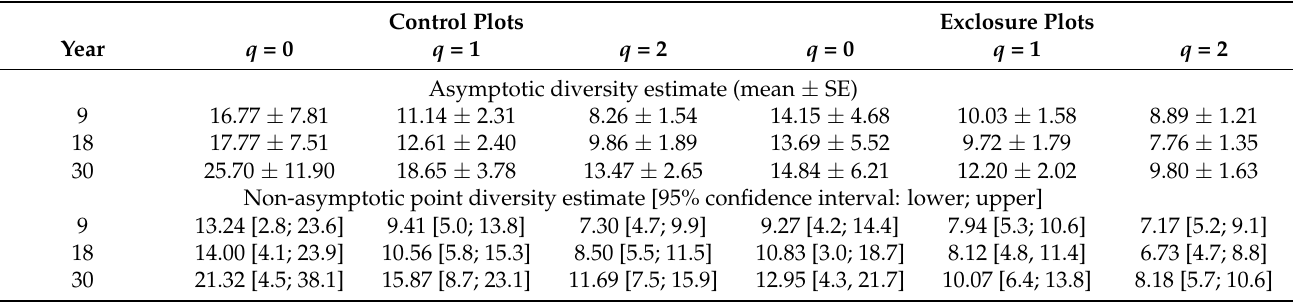
Figure 5. Empirical diversity profiles of sample-based rarefaction (solid lines) and extrapolation (dashed lines) curves for incidence-based shrub species data collected on control plots (green, point) and exclosure plots (purple, triangle) for Hill numbers of order q ( q = 0, species richness; q = 1, Shannon diversity; q = 2, Simpson diversity), ( a ) 9 years, ( b ) 18 years, and ( c ) 30 years after establishment of study plots. The 95% confidence intervals were obtained from bootstrapping based on 400 replications. Please note the different, scaled y-axes in the diagrams. Table 7. Asymptotic and non-asymptotic diversity estimates for incidence-based shrub species data collected within control and exclosure plots in Austria 9, 18, and 30 years after establishment of study plots. Non-asymptotic rarefaction and extrapolation analyses are based on point diversities for a specified sample coverage of C max = 90.1%. Numerical values for Hill numbers of order q ( q = 0, height class richness; q = 1, Shannon diversity; q = 2, Simpson diversity).